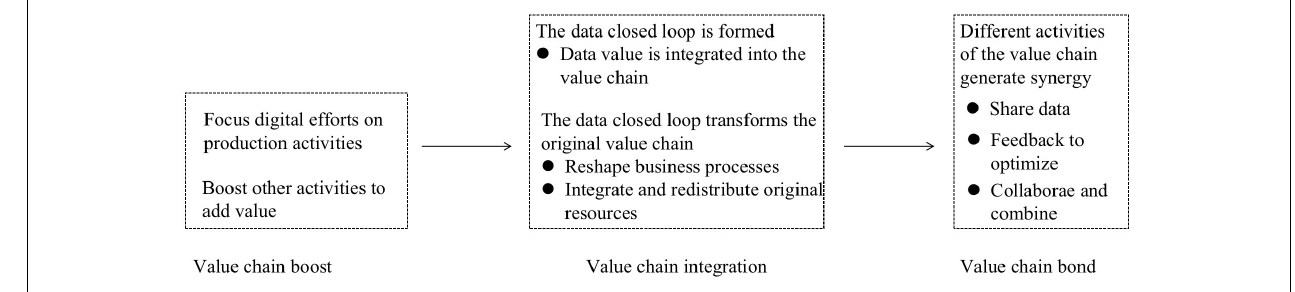
FIGURE 2 | Value chain reconfiguration path.